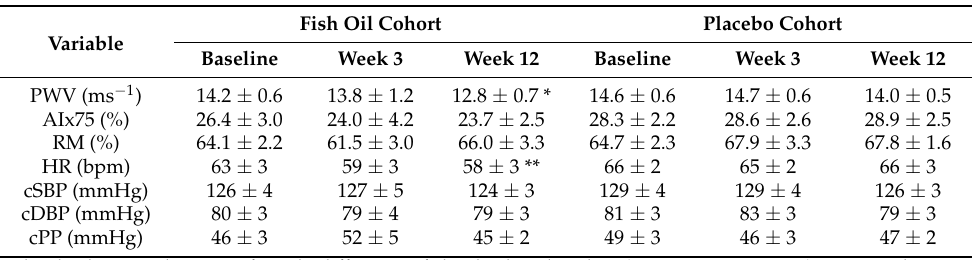
Table 2. Vascular stiffness, heart rate and central blood pressure indices at baseline and weeks 3 and 12 post treatment (mean ±